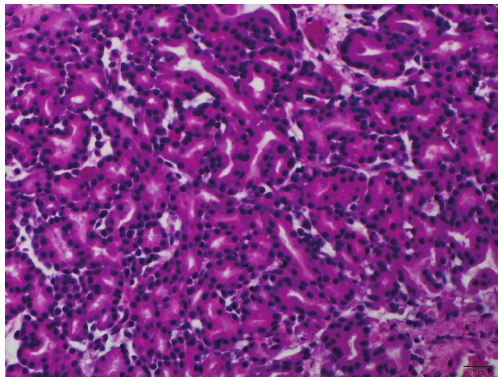
Figure 3: Histopathology of nasal mass, hematoxylin and eosin stain, 40x objective.